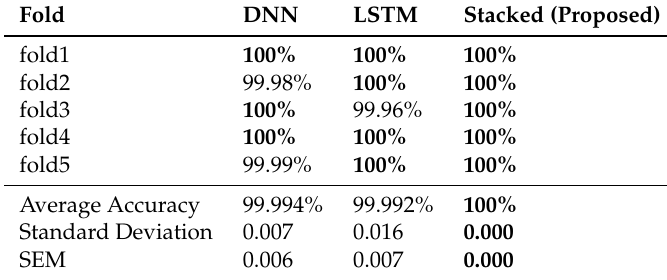
Table 2. Results of classifiers’ performance in terms of 5-fold cross-validation; best results are indicated with